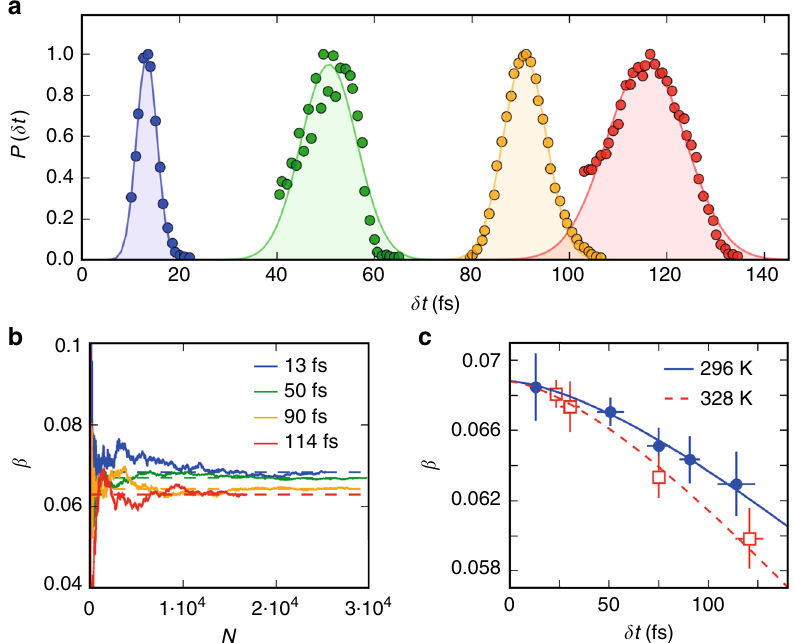
Fig. 3 Pulse duration dependence. a The temporal probability distribution of X-ray shots for variable target pulse durations δ t . b The cumulative average of the speckle contrast β for increasing number of shots N at T = 296 K for different target pulse durations as indicated in the legend. The dashed lines indicate the total average. c Speckle contrast β as a function of pulse duration δ t for two different temperatures T = 296 K and 328 K. The maximum contrast β 0 for the current settings is estimated ( β 0 = 0.069 ± 0.001) by its value at δ t = 0. The vertical error bars are the standard error and the horizontal the FWHM of the pulse duration distribution. The solid and dashed lines are fi ts to the experimental